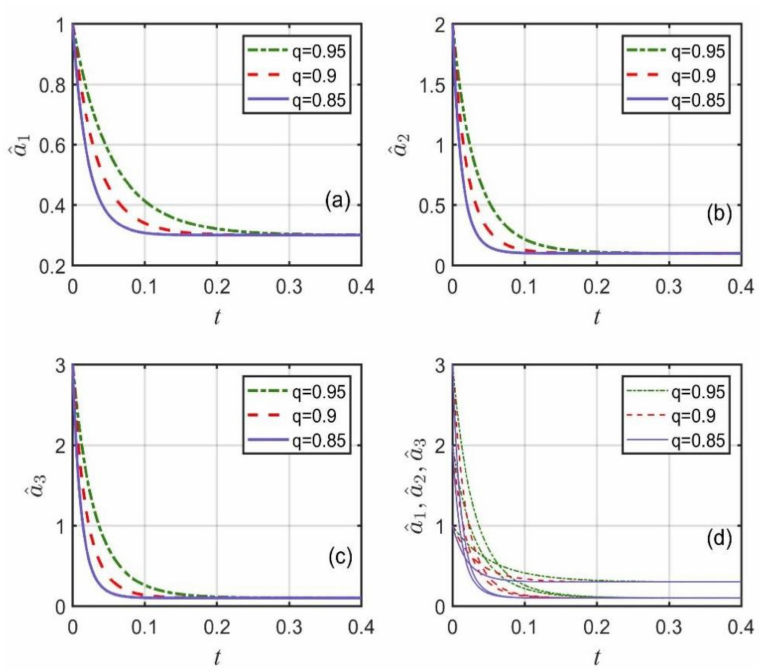
Figure 13. Identification of unknown parameters ( a ) a 1 ; ( b ) a 2 ; ( c ) a 3 ; ( d ) a 1 , a 2 and a 3 with some different fractional